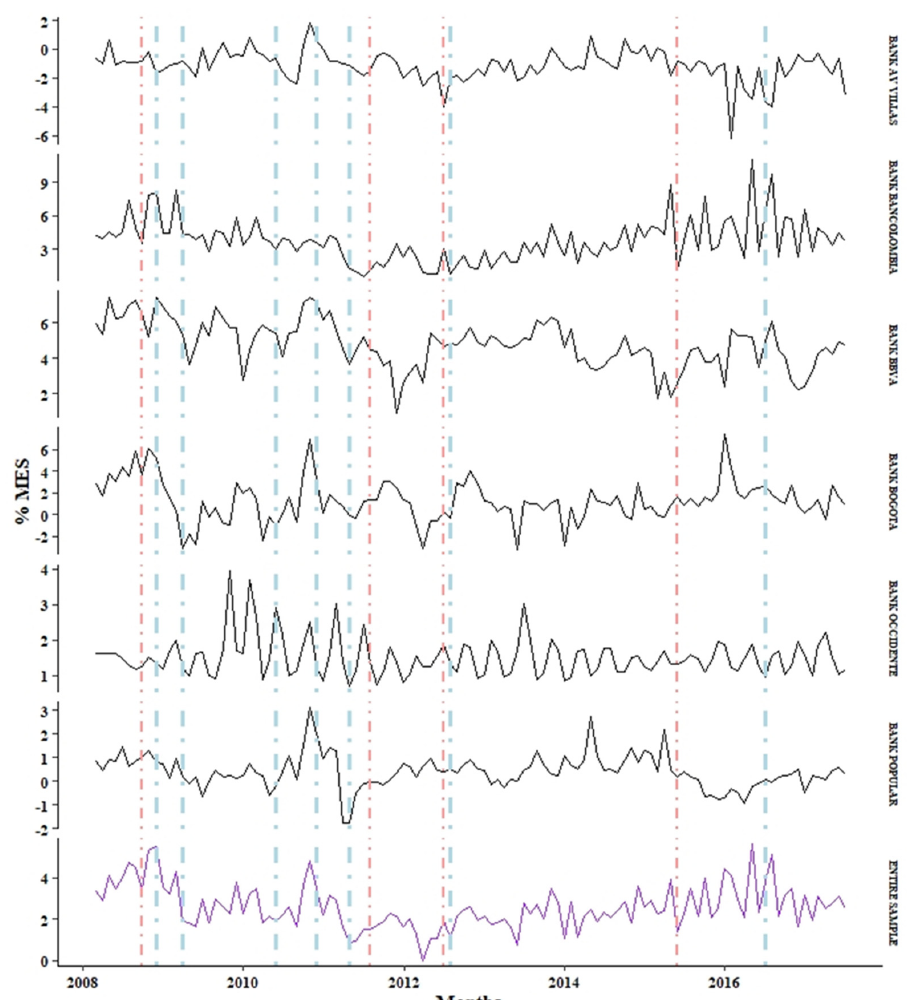
Figure 6. Monthly behavior of the MES systemic risk measure for both banks and the entire sample. Source: Owner.